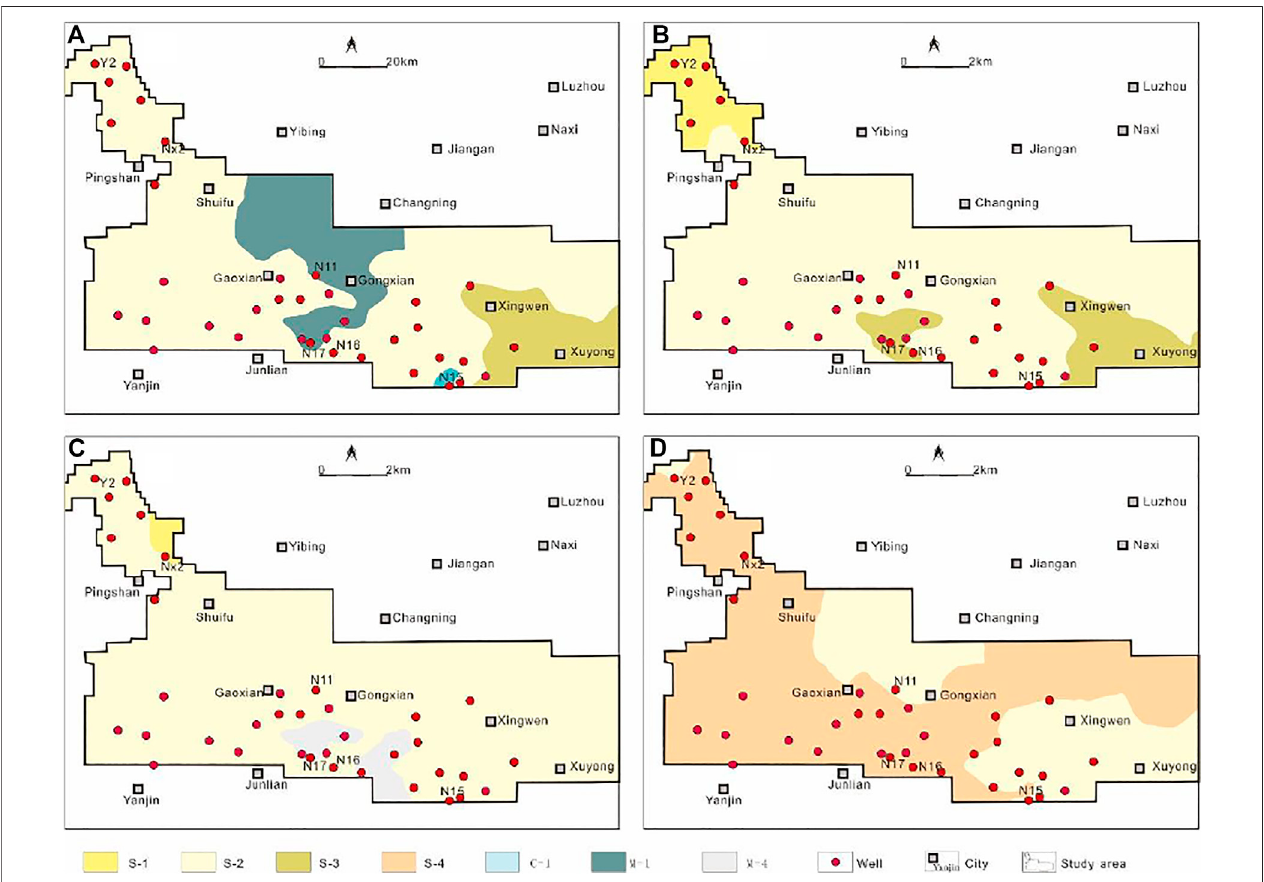
FIGURE7| Spatialdistributioncharacteristics ofshalelithofaciesindifferentsections oftheLongmaxiFormation intheChangningarea. (A) Lithofaciesdistribution of the Long11-1 section. (B) Lithofacies distribution of the Long11-2 section. (C) Lithofacies distribution of the Long11-3 section. (D) Lithofacies distribution of the Long11-4